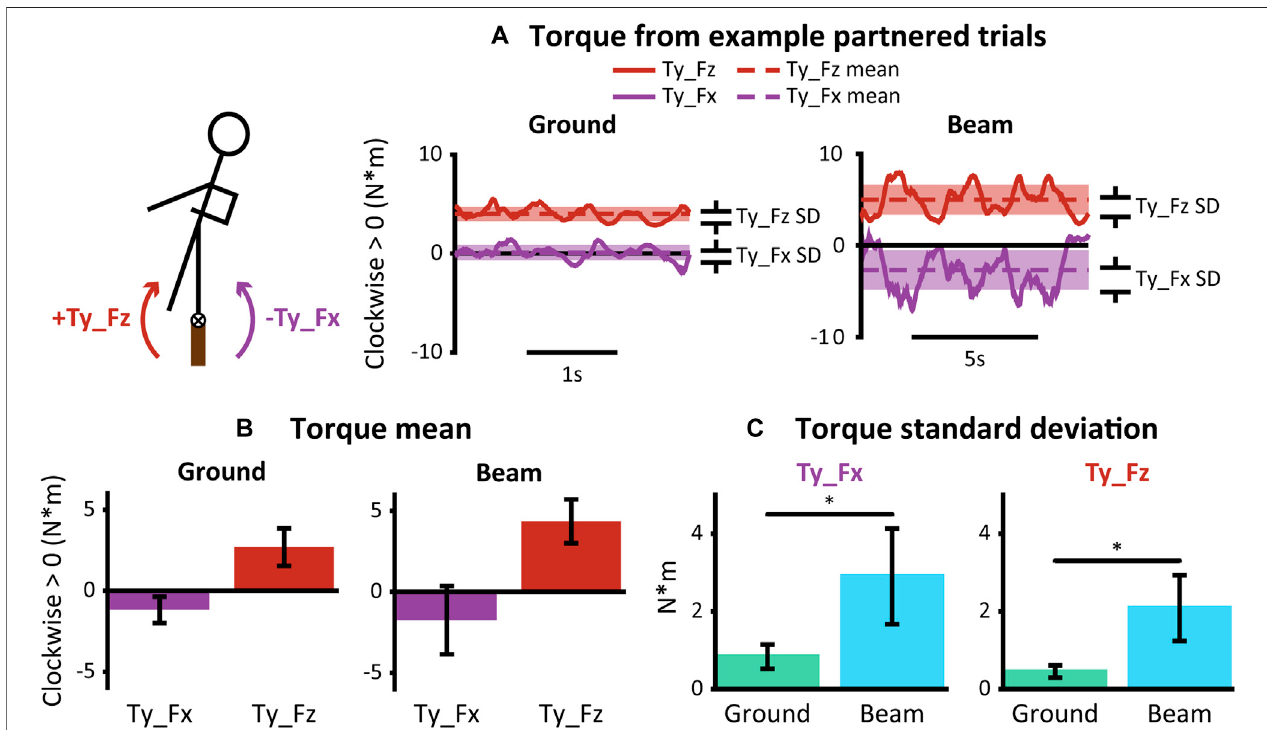
FIGURE 5 | Torques on beam-walker ’ s body due to hand forces during partnered walking * t -test p < 0.05. Error bars represent ± one standard deviation. (A) Torquesduetolateral(Ty_Fx)andvertical(Ty_Fz)handforcesduringexampletrialsofoverground(left)andbeam(right)walking.Standarddeviationswerecalculatedper trialto quantify magnitude of balance assistance. Means were calculated per trial to distinguish directionality. (B) Torque means for all participants. Means for Ty_Fx and Ty_Fz were different from zero and opposite in sign for both overground (left) and beam (right) walking. (C) Torque standard deviations for all participants.